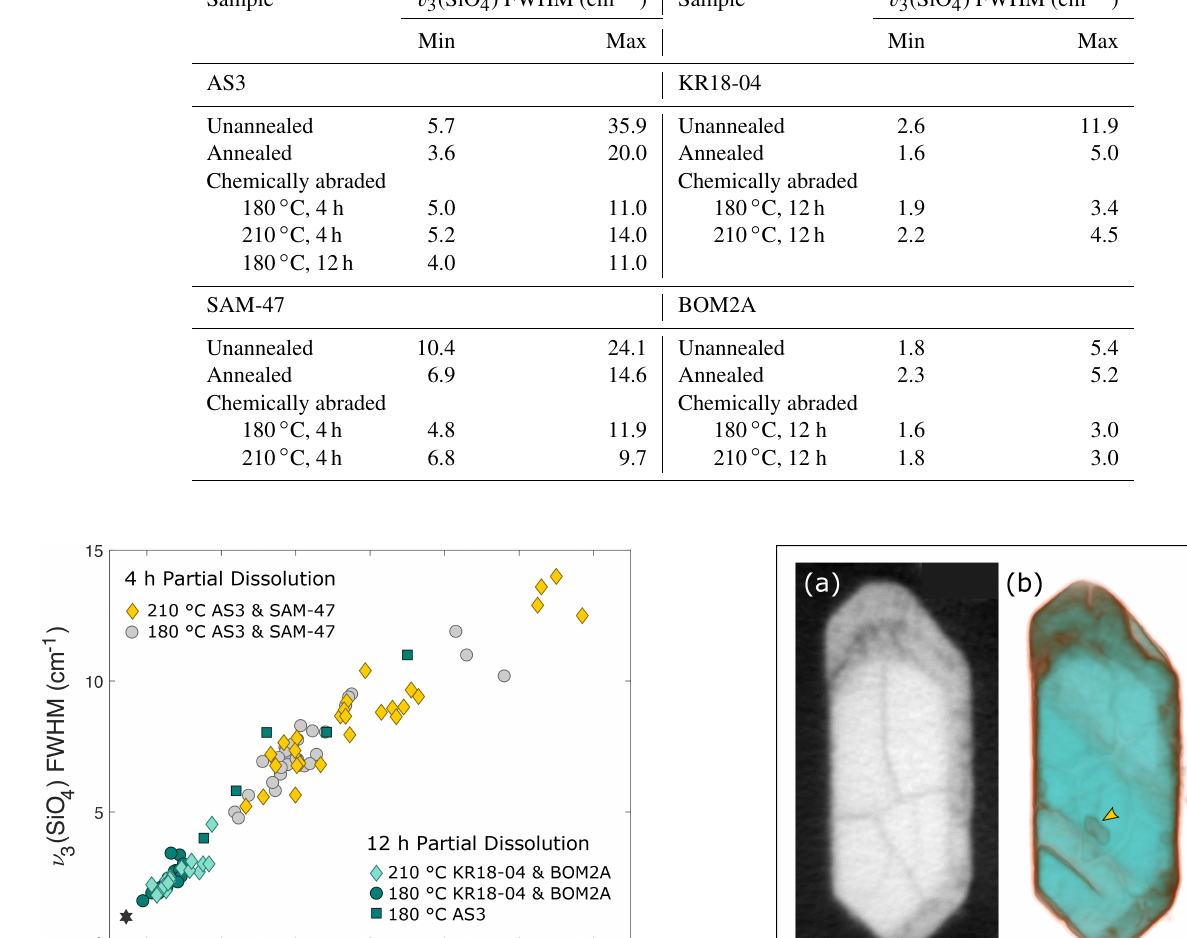
Table 2. Minimum and maximum v 3 (SiO 4 ) FWHM values for unannealed, annealed, and chemically abraded zircon samples. Sample